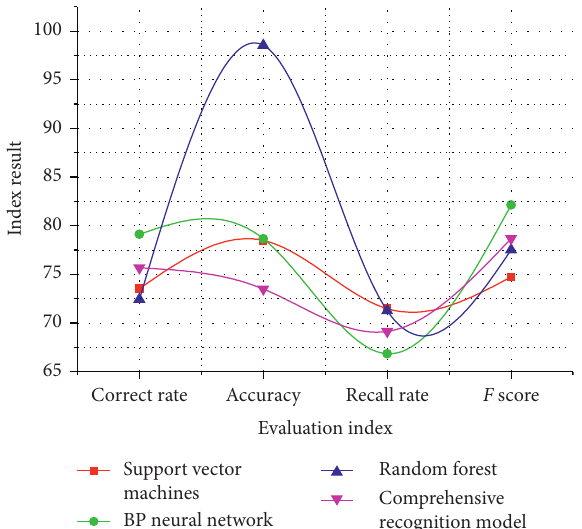
Figure 7: Calculated results of each model metric.